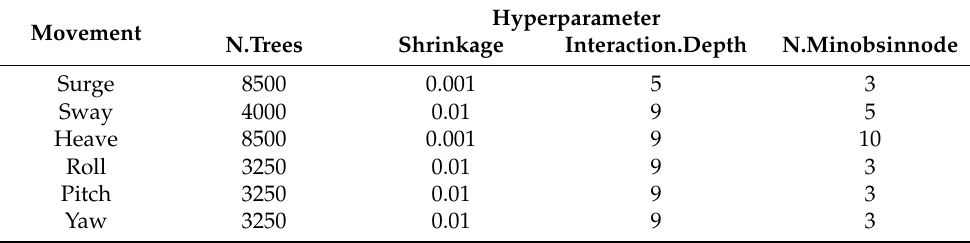
Table 2. Gradient boosting: best models’